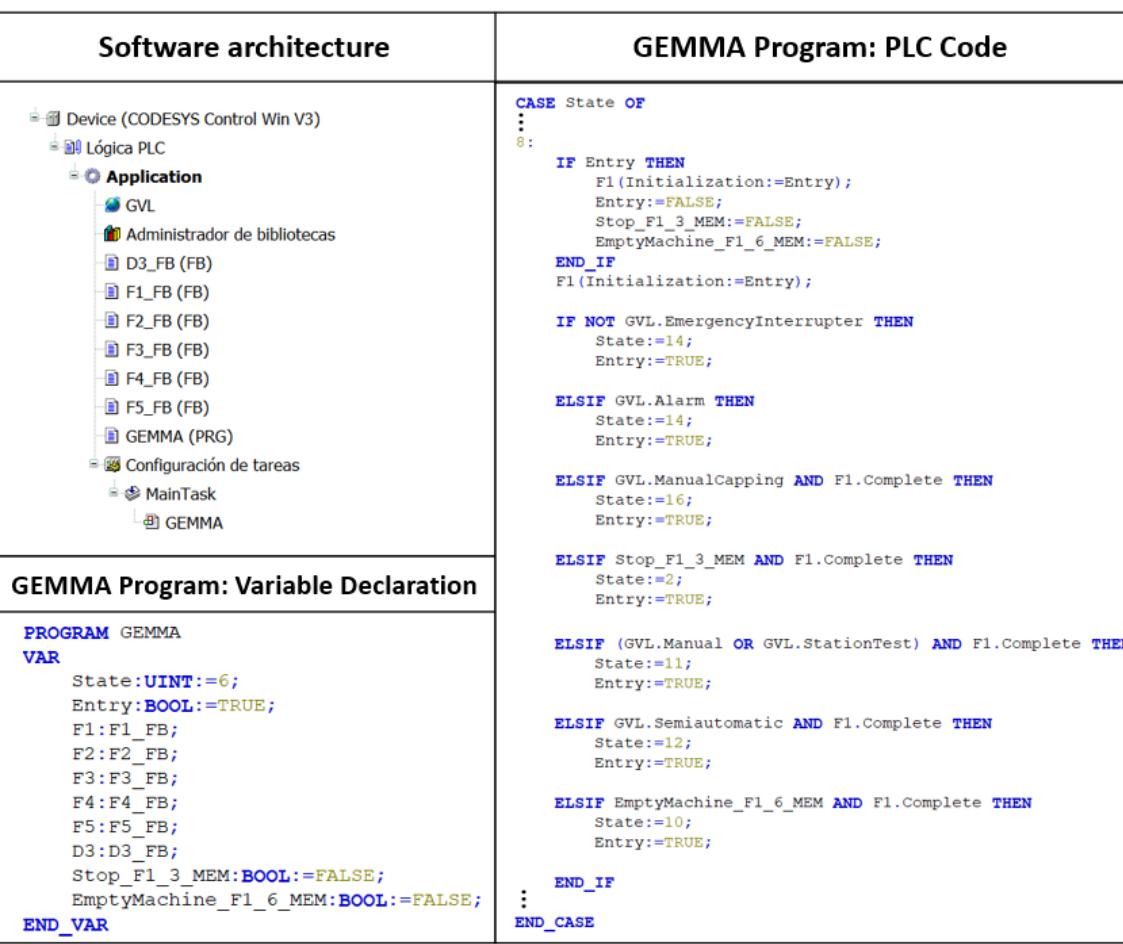
Figure 8. Part of the PLC code generated for the filling and encapsulating machine. It can be noticed that the transition to the state D1 (i.e., state 14) has the highest priority—since it acts at the ’F family’ level—and makes the F1 state behave as an enclosing